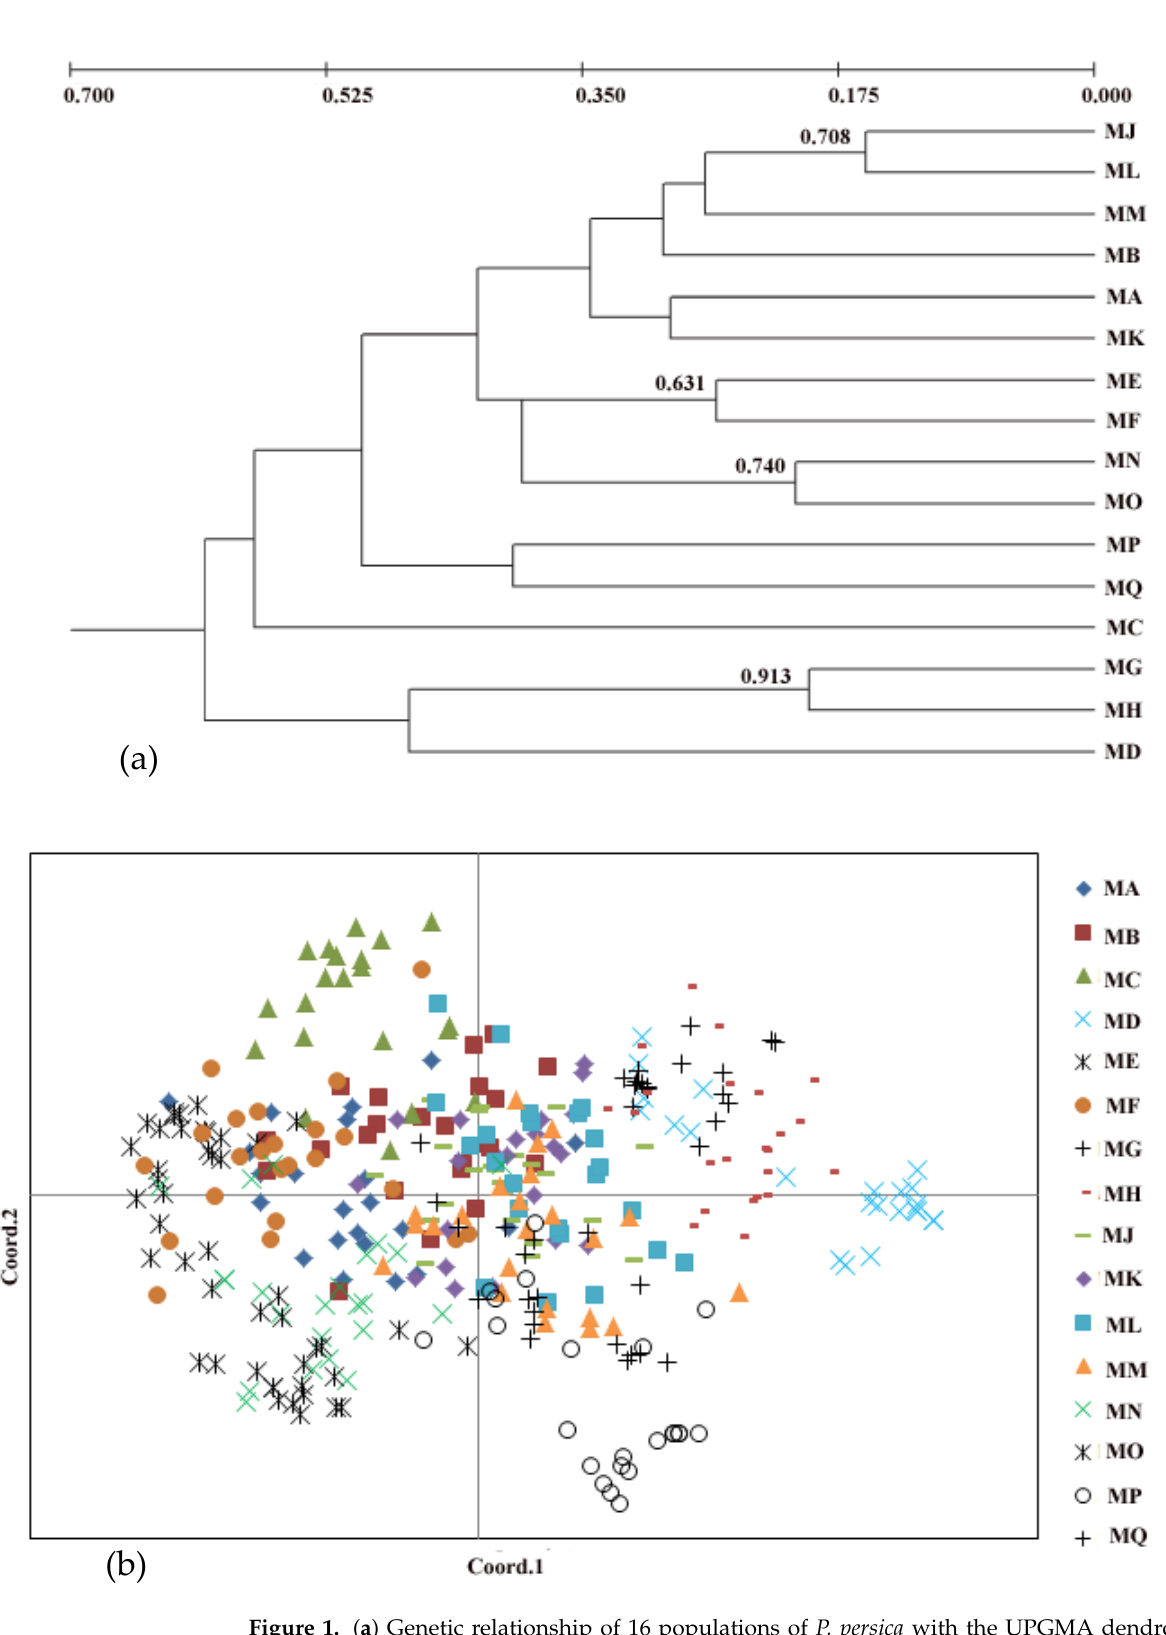
Figure 1. ( a ) Genetic relationship of 16 populations of P. persica with the UPGMA dendrogram: bootstrap percentage (>50%) are given above branches; ( b ) principal coordinates analysis for 16 populations.